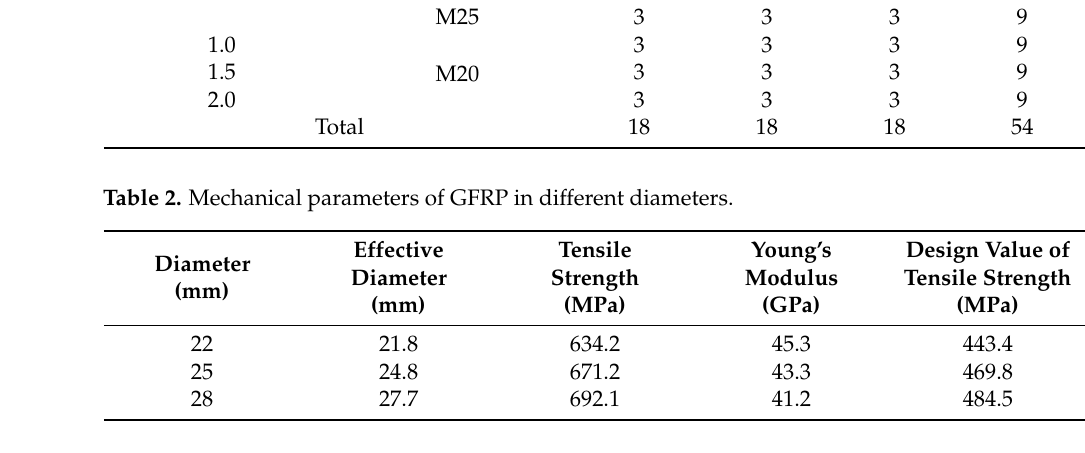
Table 3. Mortar mix proportions in different strength grades.